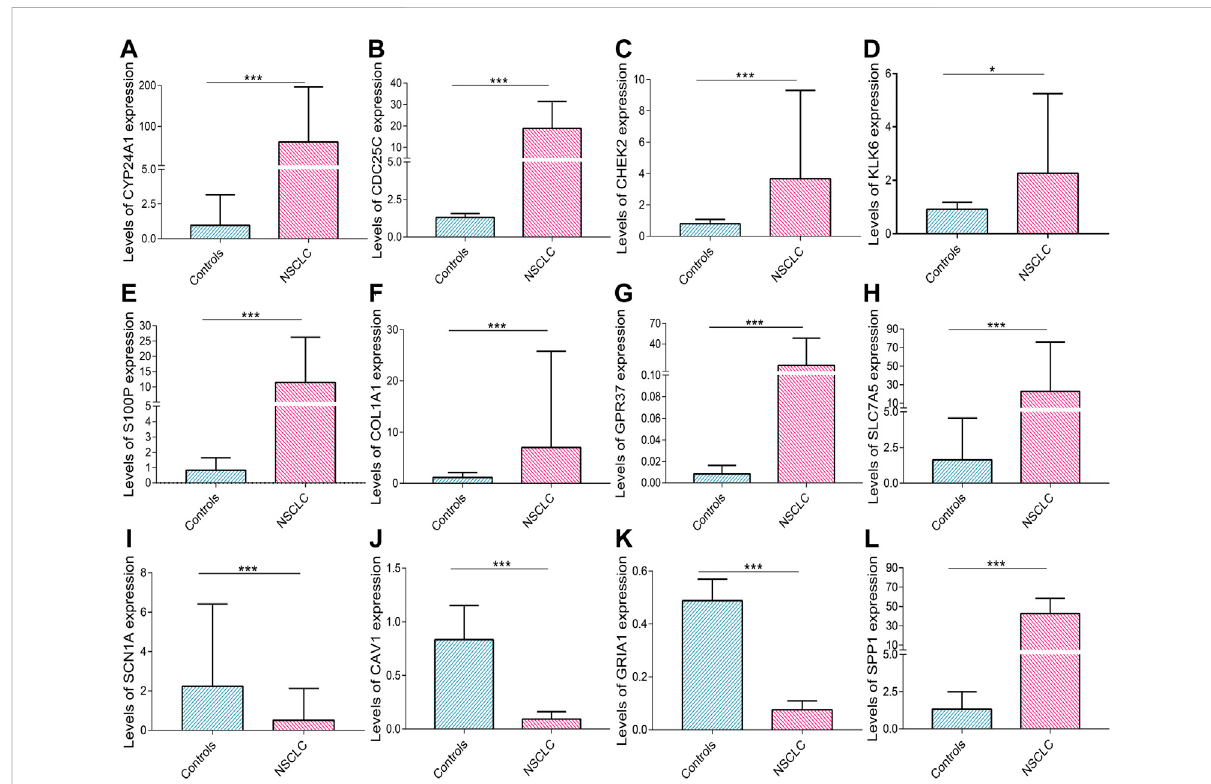
FIGURE 11 Real-timePCRvalidation.Thelevelsof (A) CYP24A1, (B) CDC25C, (C) CHEK2, (D) KLK6, (E) S100P, (F) COL1A1, (G) GPR37, (H) SLC7A5, (I) SCN1A, (J) CAV1, (K) GRIA1,and (L)